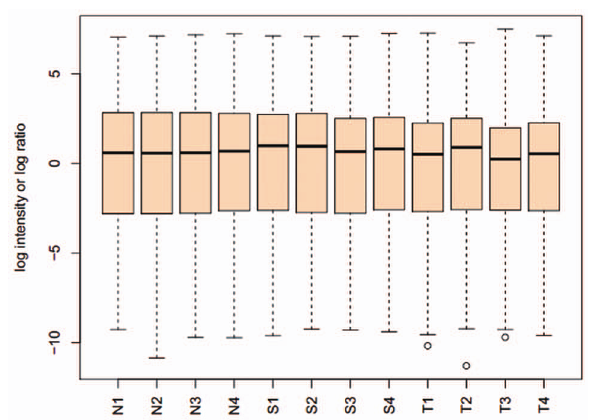
Figure 1. Boxplots of log ratio of 12 samples’ raw microarray data. After the log 2 transfer and normalization, all samples showed